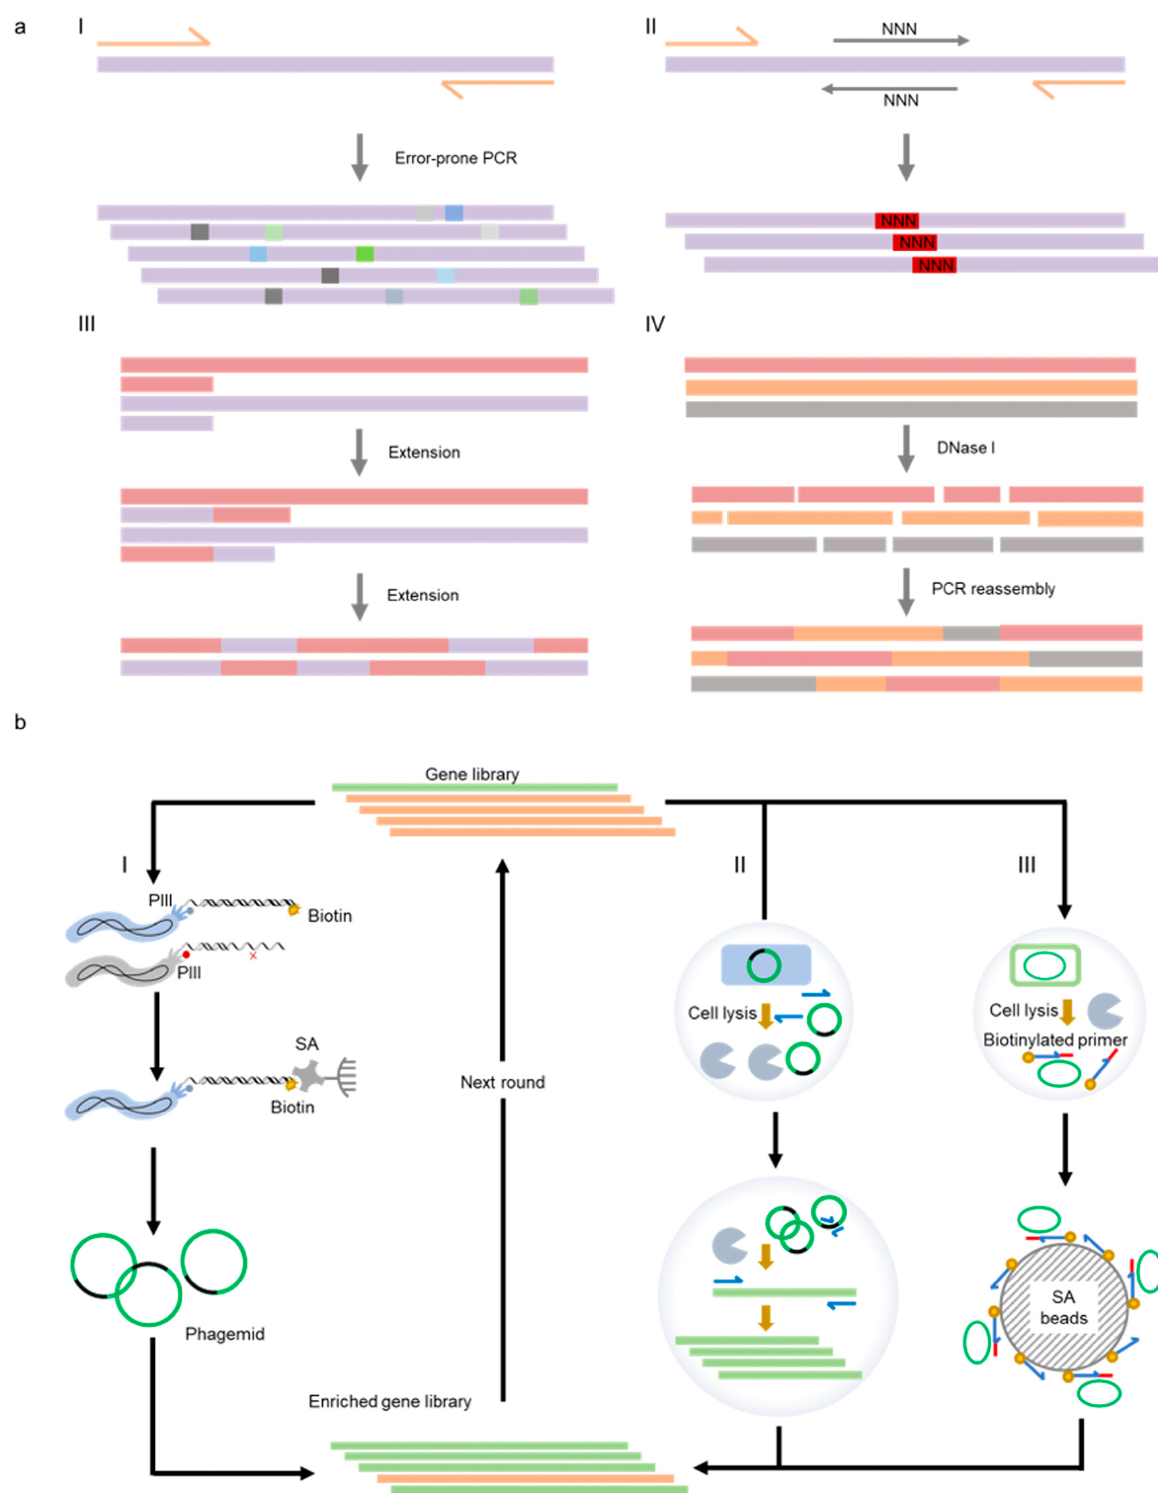
Figure 3. Representative methods employed for the generation of XNAPs. ( a ) Methods for the construction of polymerase libraries. I: error-prone PCR; II: site-directed saturation mutagenesis; III: gene shuffling by StEP; IV: gene shuffling by DNase I digestion and PCR reassembly; ( b ) methods for the selection of polymerase mutants. I: phage display; II: CSR; III: CST.